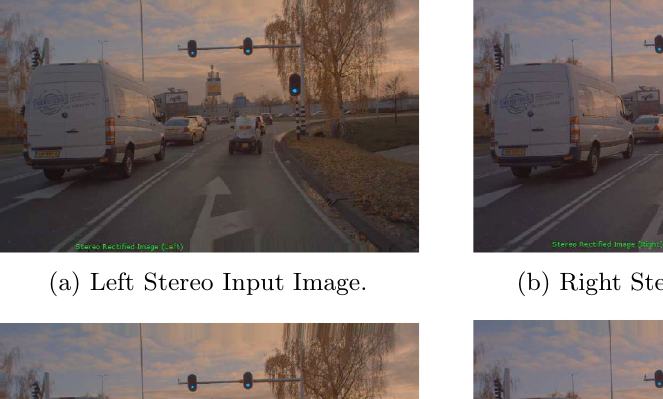
(c) Left Rectified Image. (d) Right Rectified Image.